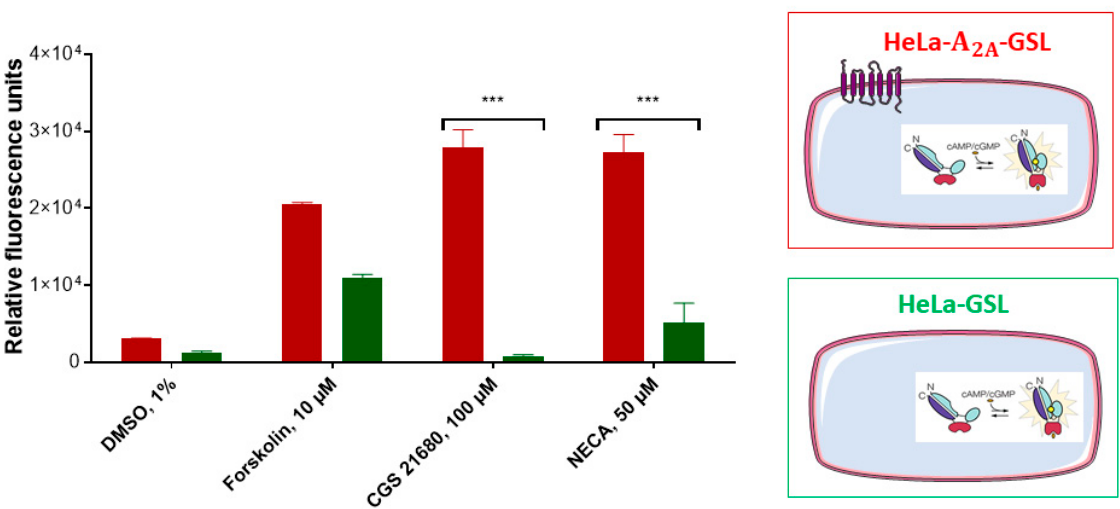
Figure 4. Assessment of adenosine receptor-mediated cAMP production in A 2A AR-transfected (red) and nontransfected (green) HeLa- cells. The cAMP-activated GloSensor luciferase was cotransfected resulting in cAMP-dependent luminescence signals. Cells (60,000/well) were incubated with medium supplemented with 2% GloSensor luciferase reagent for 2 h at 37 ◦ C. After addition of DMSO or compound dissolved in DMSO (forskolin, 10 µ M, CGS-21680, 100 µ M, or NECA, 50 µ M) the cells were incubated at 37 ◦ C for 15 min. Signals induced by adenosine receptor agonists CGS-21680 or NECA were significantly different between both cell lines (*** p < 0.001, 2-way ANOVA). For details see Materials and Methods.